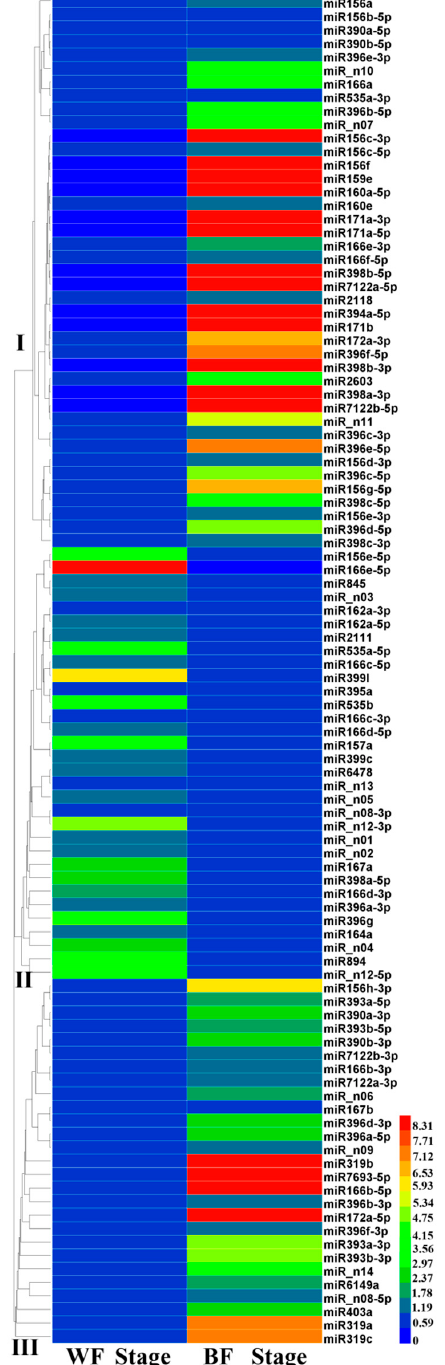
Figure 3. Expression analysis of known and novel miRNAs from blueberry obtained from the sequencing data. miRNAs were grouped into 3 classes (I–III) based on their accumulation patterns. WF and BF refer to white fruit and blue fruit, respectively.